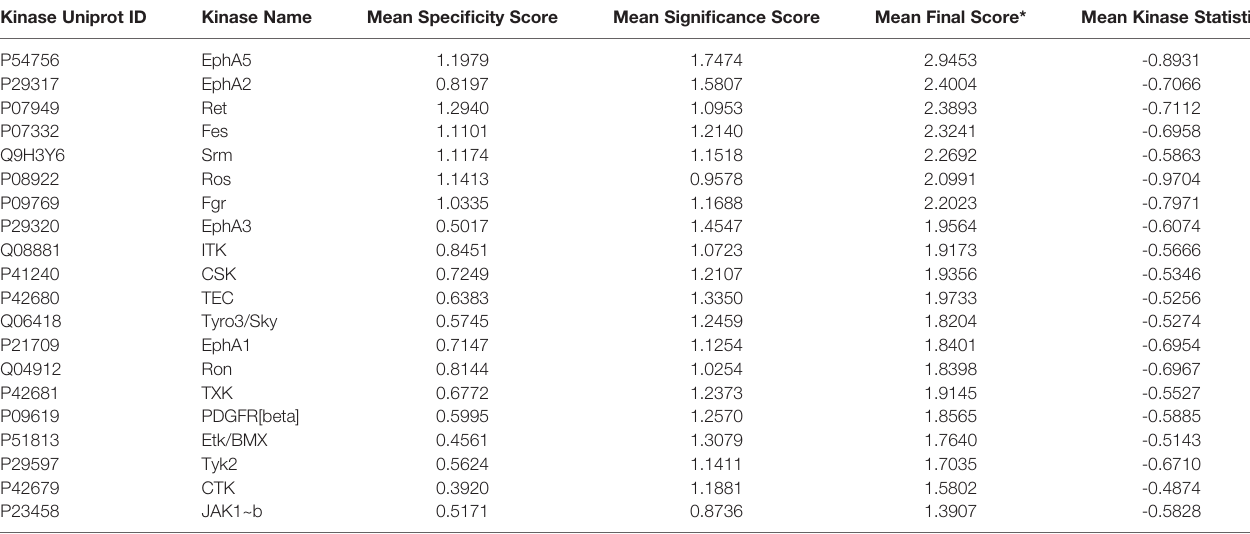
TABLE 5 | Top 20 affected kinases ranked according to Kinase Scores for 4e at 0.1 µM treatment of HL60 leukemia cell lines.